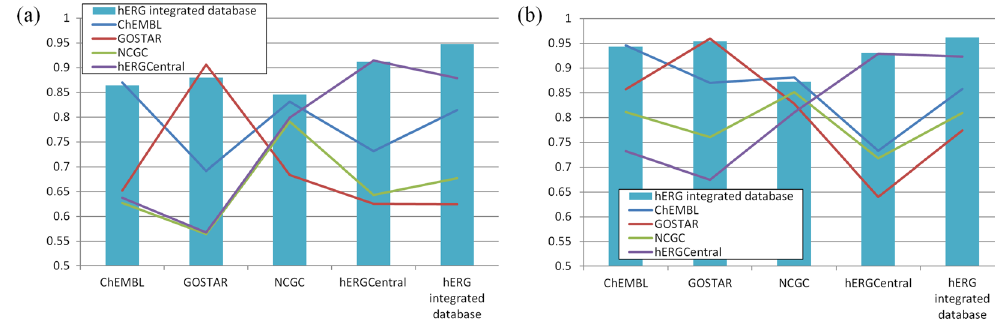
Figure 3. The ROC scores of the SVM models built from the hERG integrated database (light blue bar), ChEMBL (blue line), GOSTAR (red line), NCGC (green line), and hERGCentral (purple line), using ( a ) ECFP4, ( b ) ECFP4 and 72 descriptors as the explanatory variables. The horizontal axis corresponds to the data source of the test set.